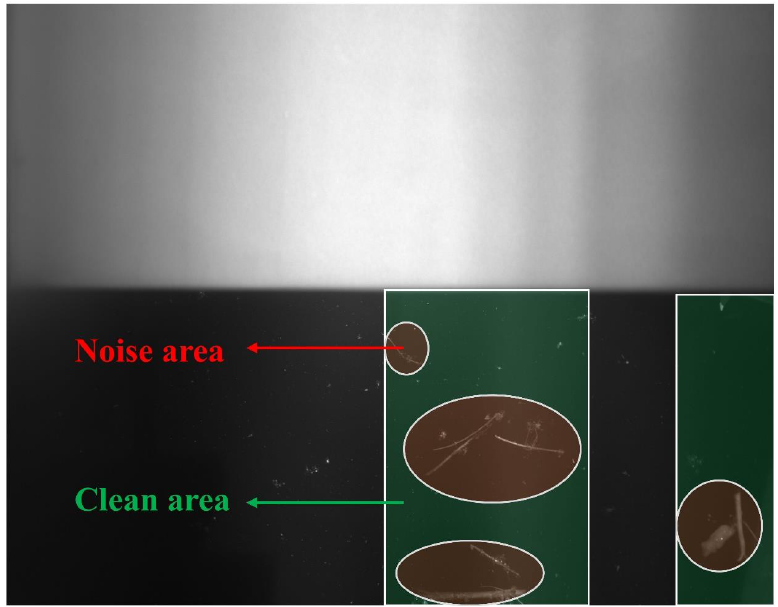
Figure 5. The self-developed spectral denoising method. The red in the highlighted areas represents the noise area, and the green represents the replaceable clean area.